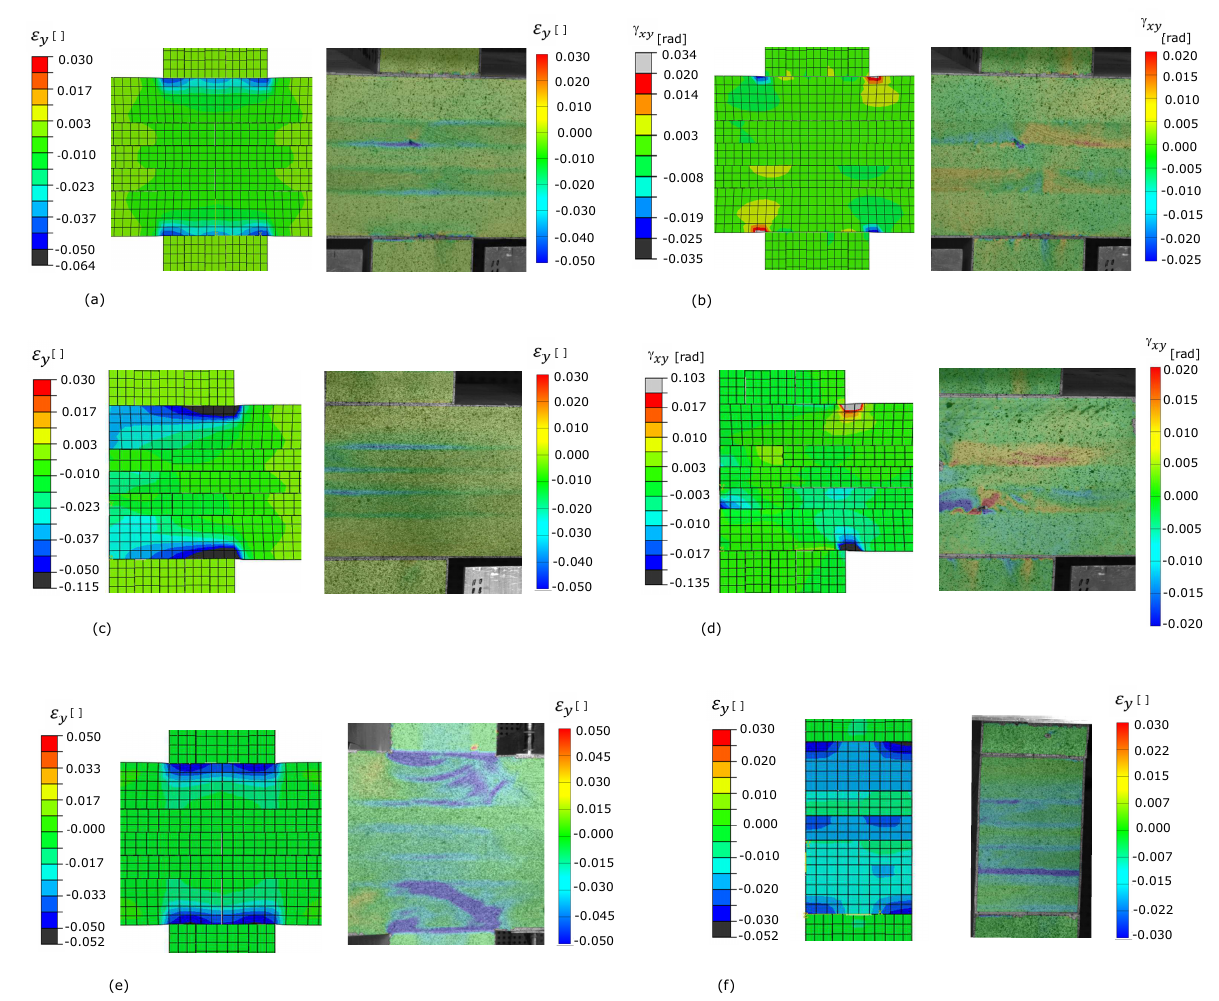
Figure 10. Strain distributions from numerical model ( left ) and experiments ( right ) for W100-F140-ww-cen setup: ( a ) compressive strain and ( b ) shear strain; for W100-F140-ww-edge setup: ( c ) compressive strain and ( d ) shear strain; ( e ) compressive strain for W80-F140-ww90-cen and ( f ) W80-F140-full comp. at about 2.5 mm global displacement.